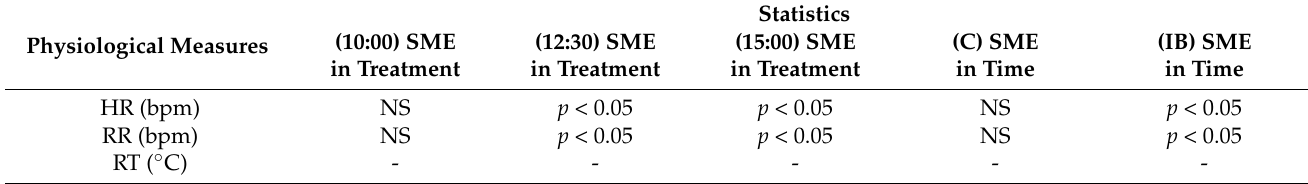
Table 8. Statistics 2 of heart rate (HR), respiratory rate (RR), and rectal temperature